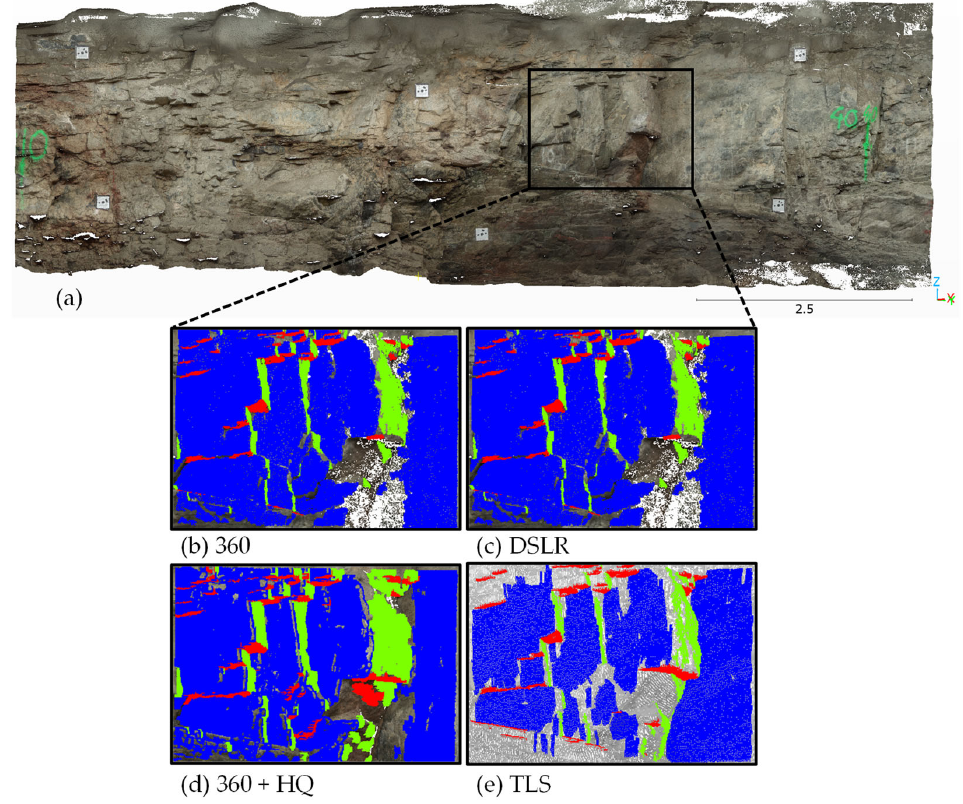
Figure 12. Rock mass mapping window on the tunnel wall ( a ) with three extracted rock discontinuity sets (red, green, and blue colored points) extracted with the Discontinuity Set Extractor from the point clouds: ( b ) 360-degree model, ( c ) DSLR model, ( d ) 360-degree and HQ model, and ( e ) reference TLS model.